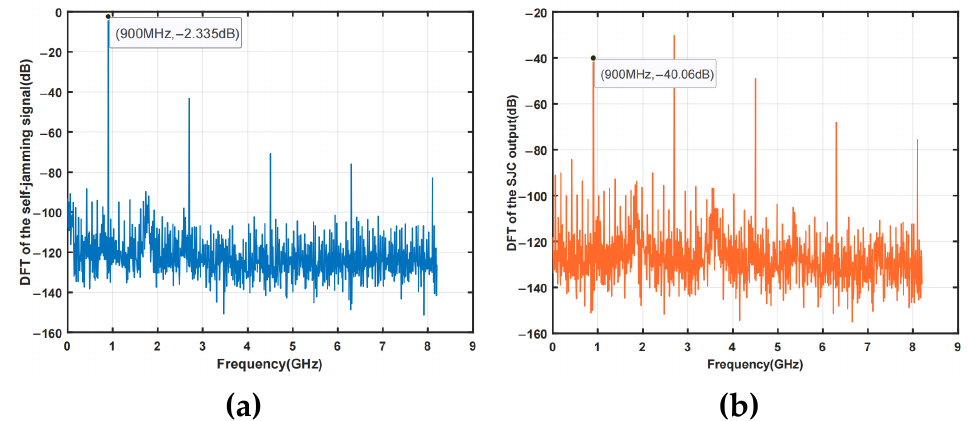
Figure 18. Suppression performance of the proposed SJC circuit: ( a ) amplitude of the self-jamming signal; ( b ) amplitude of the SJC output.